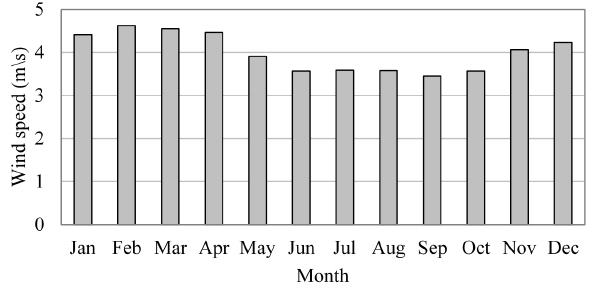
Figure 9. Monthly average wind speed for South Korea [26,27].